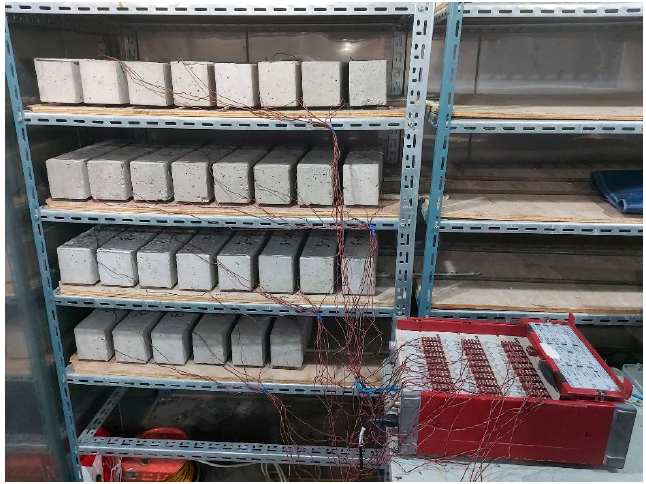
Figure 4. Drying shrinkage test.